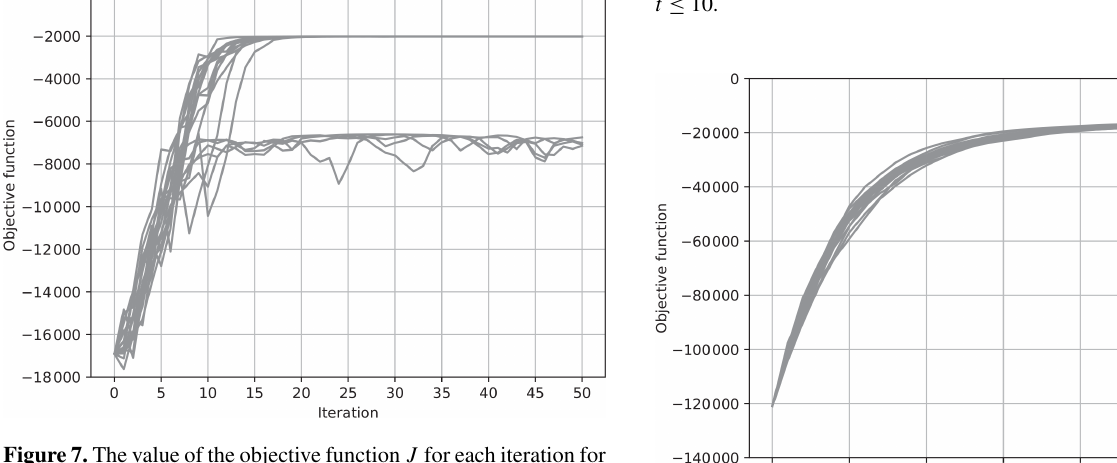
Figure 8. The value of the objective function J for each iteration for 20 trials of the estimation. The ensemble was updated using Eq. (36) with δ = 1 . 5 × 10 − 2 , and the ensemble window was taken as 0 < t ≤ 10.